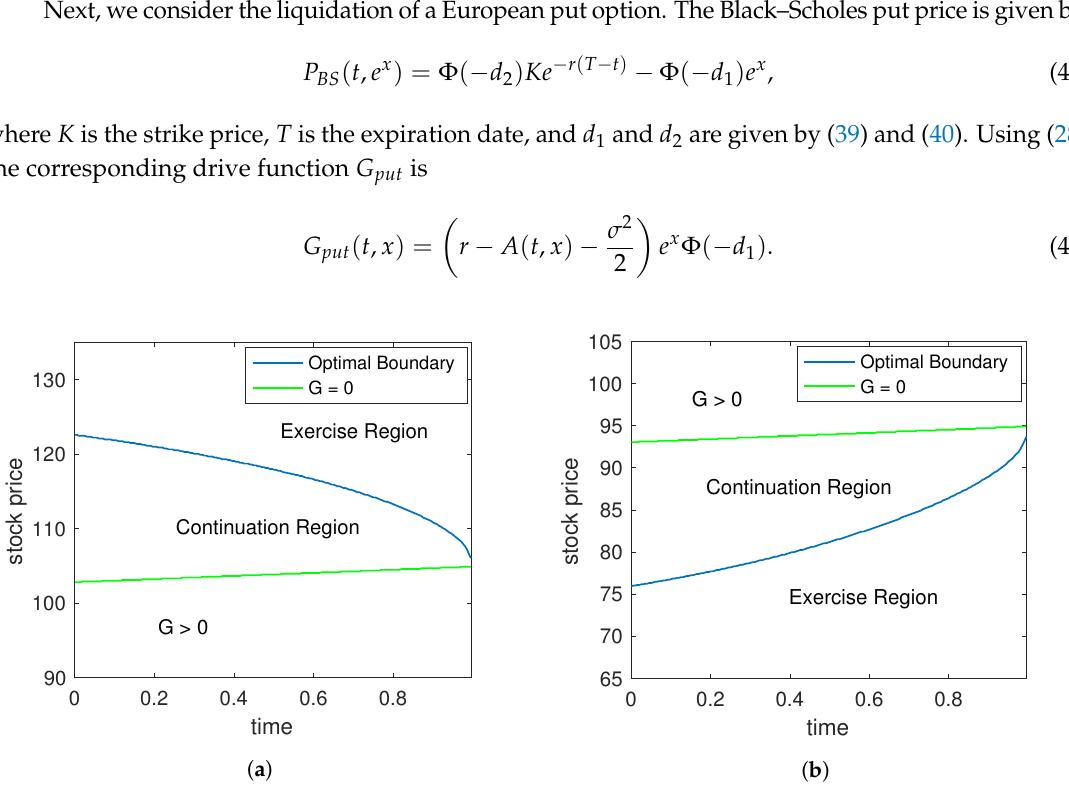
Figure 7. Optimal boundaries for selling European call with S 0 = 105 ( a ) and put with S 0 = 95 ( b ) under normal distribution. The strike price K = 100 and maturity T = 1, and the other parameters: µ = 0, σ D = 0.1, r = 0.1, ¯ T = 1, σ = 0.4. The green line is defined by G = 0, and continuation region contains G ≥